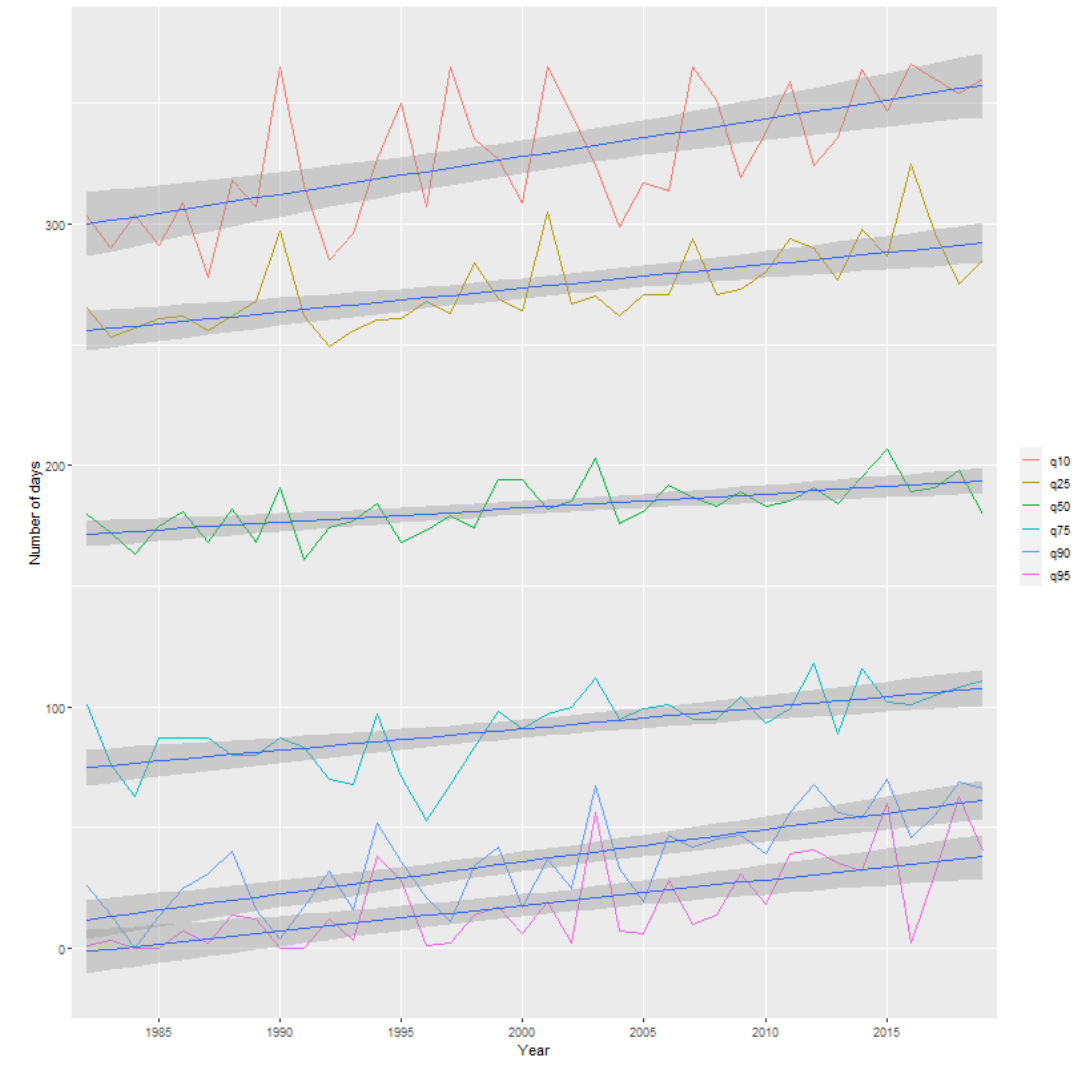
Figure 9. Number of days exceeding the statistical percentiles in a natural year for the mean Mediterranean